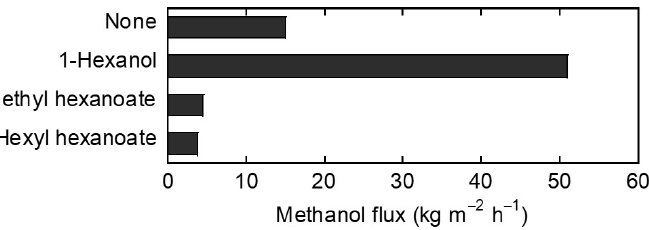
Figure 6. Methanol flux through FAU-type zeolite membranes at 333 K after 8 h vapor exposure to untreated, 1-hexanol, methyl hexanoate, and hexyl hexanoate.